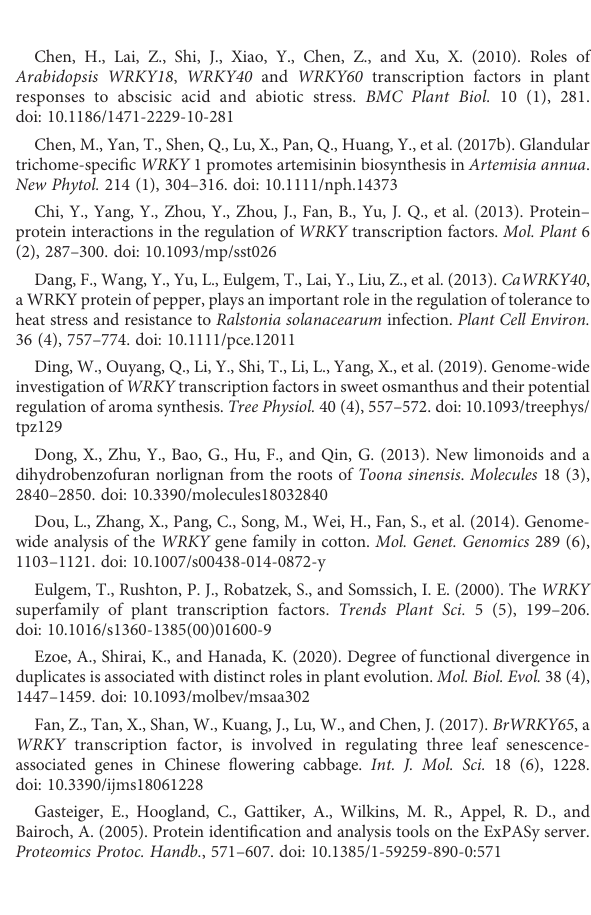
SUPPLEMENTARY FIGURE 1 A phylogenetic tree of WRKY domains from T. sinensis and A. thaliana. SUPPLEMENTARY FIGURE 2 A phylogenetic tree of WRKY domains from T. sinensis and other species in the green